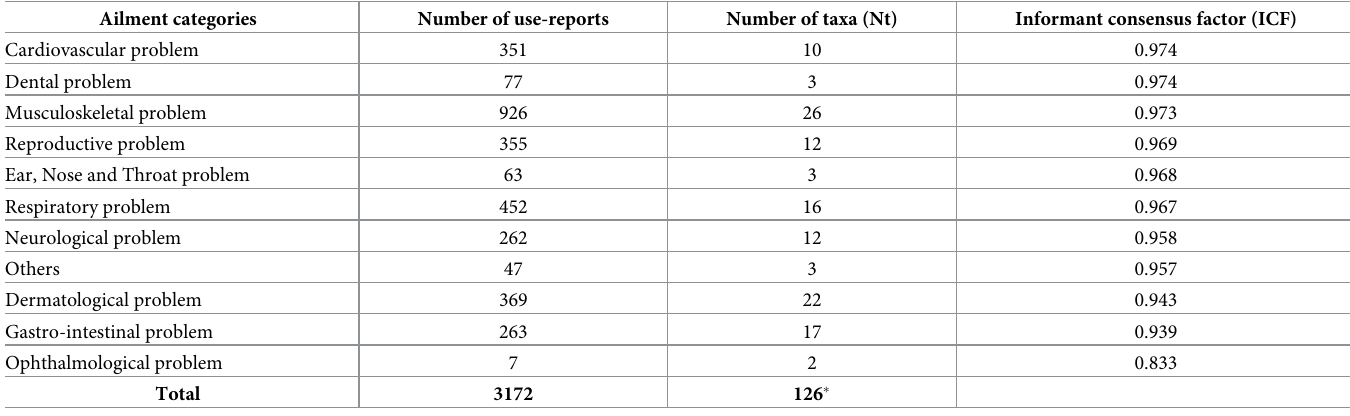
Table 4. Categories of ailments and informant consensus factor (ICF) for these